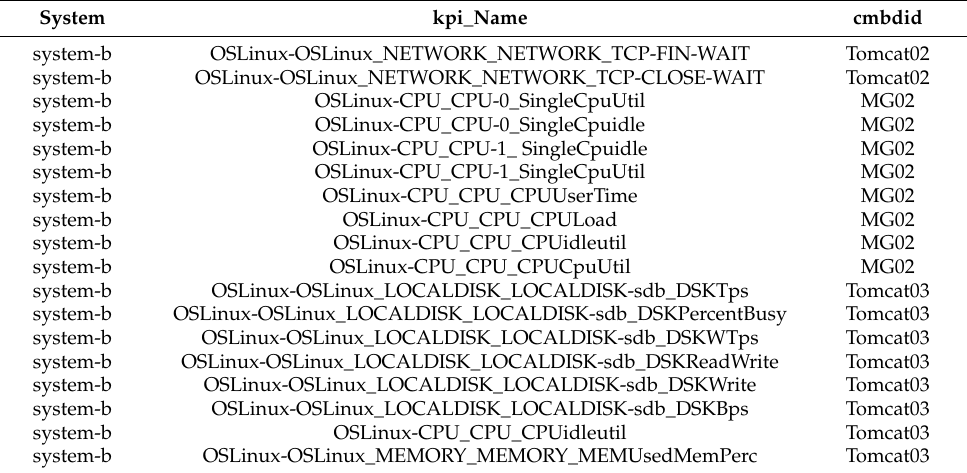
Table 1. Information about KPIs used in experiments. “System” represents the system wherein each KPI is located, “kpi_name” shows the KPI name, and “cmbdid” shows the service node whereat each KPI is located.